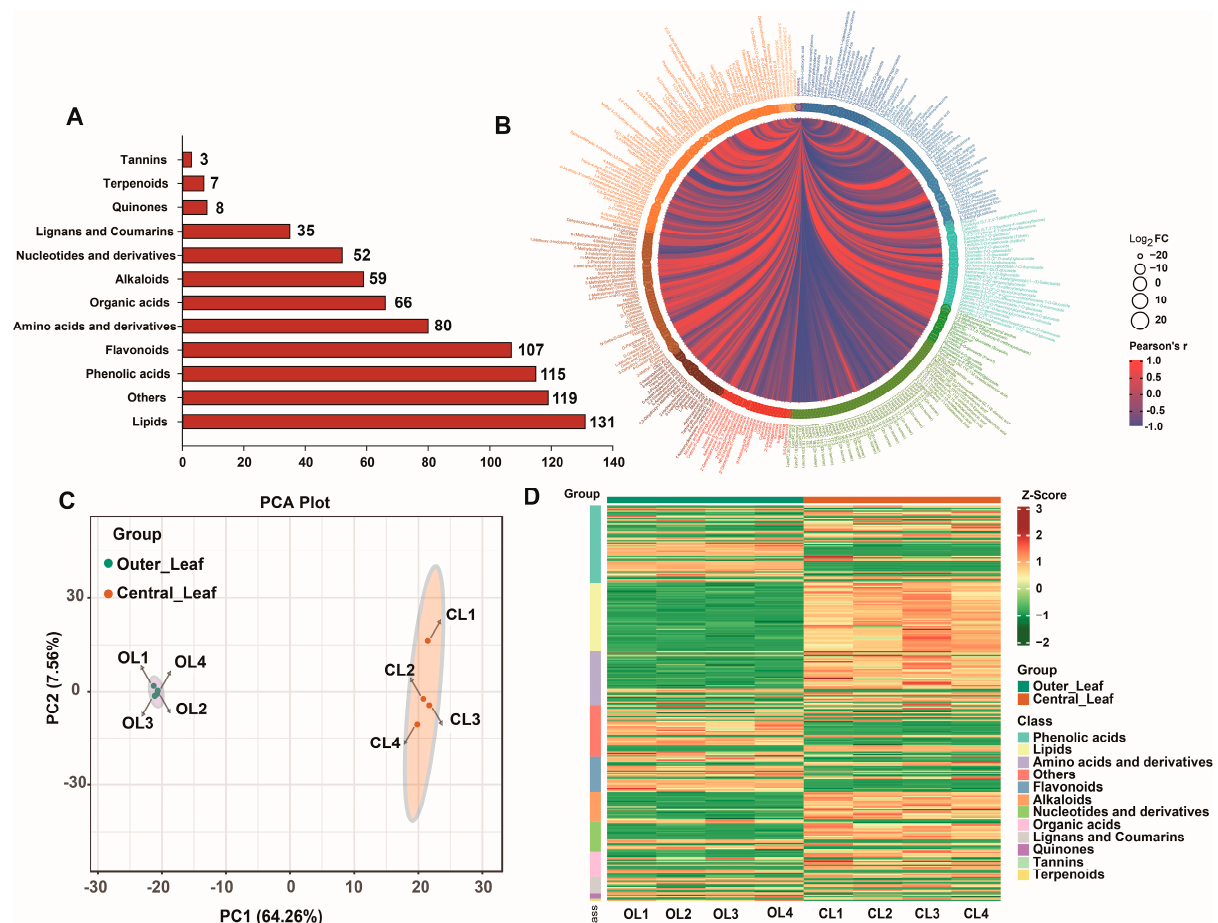
Figure 2. Overview of the metabolites: ( A ) categorical statistics of the metabolites; ( B ) correlations between the metabolites; ( C ) principal component analysis of the samples; and ( D ) clustering heat map of the metabolites.